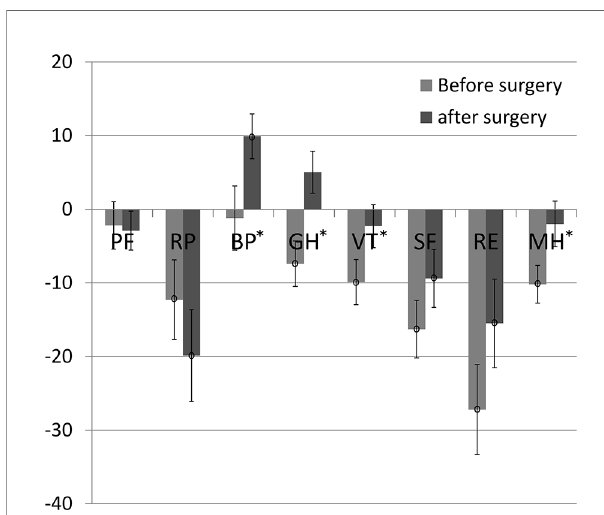
FIGURE 1 | SF-36 pre- and post-data in comparison to normative data. Signi fi cant changes from before to after surgery have been marked with “ * ” ; signi fi cant differences compared to the German normative data have been marked with “ ° ” at the center of the error bar, which re fl ects the standard error.